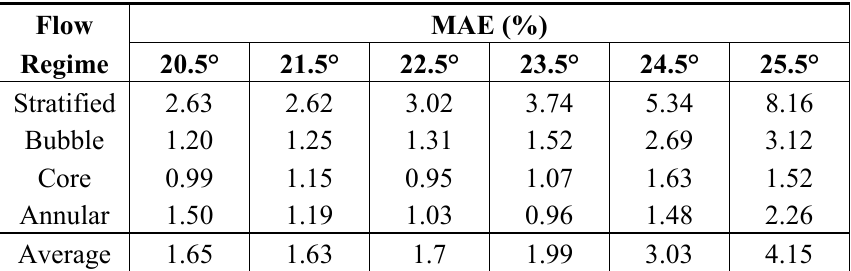
Table 5. MAEs of the best MLP using optimal principal components tested on ECT data based on various θ s.